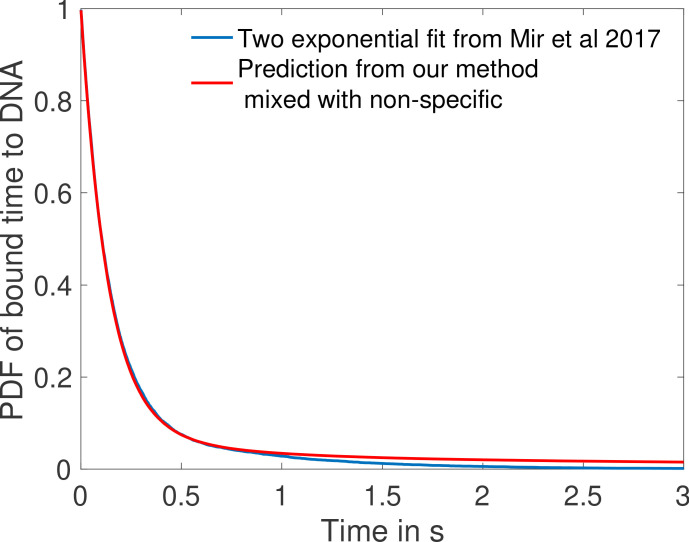
Comparison of fit to data from Mir et al., 2017 and prediction from one of the fastest architectures for time spent bound to DNA by Bicoid molecules.In blue we show the two exponential fit for the pdf of the time spent bound to the DNA by Bicoid molecules at the boundary for the Zelda null conditions in Mir et al., 2017. They fit two exponentials to the data obtaining a coefficient of determination above 0.99 for a least square fit. Their fit finds 12.9% specific traces with mean 0.629 s and 87.1% non-specific traces with mean 0.131 s. In blue we show the PDF of time spent bound to DNA for a mix of 87.1% non-specific traces with the same mean 0.131 s and 12.9% specific traces drawn from the distribution of time spent to DNA based on the fastest promoter architecture identified for k=2, H>5 (obtained from Monte Carlo simulation). Our prediction fits the blue curve from Mir et al., 2017 with a coefficient of determination above 0.99 as well.